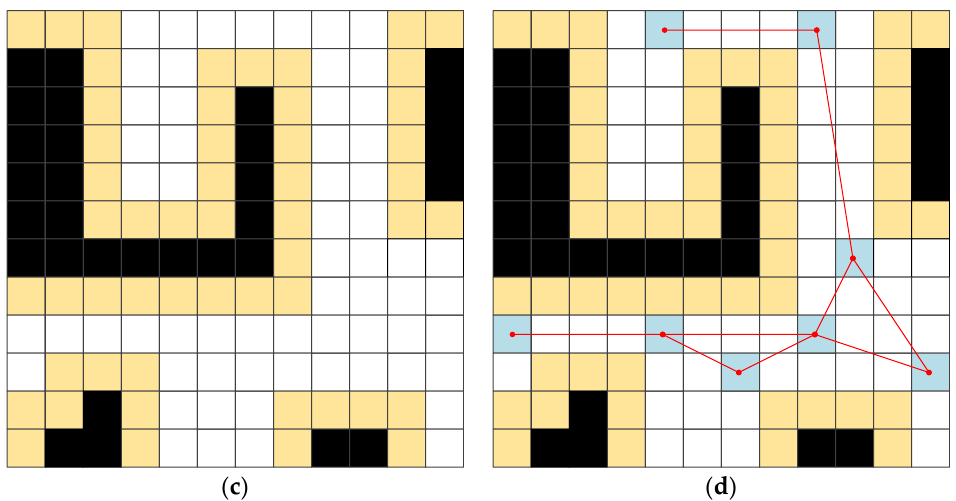
Figure 3. ( a )This is the original map. ( b ) The Euclidean distance map. Black represents occupied cells. The brightness of cells increases with distance. ( c ) The map with alert areas. The light-yellow cells denote the alert areas. ( d ) The subgoal graph. The light-blue cells represent subgoals, and the red lines signify the direct-h-reachability of adjacent subgoals.